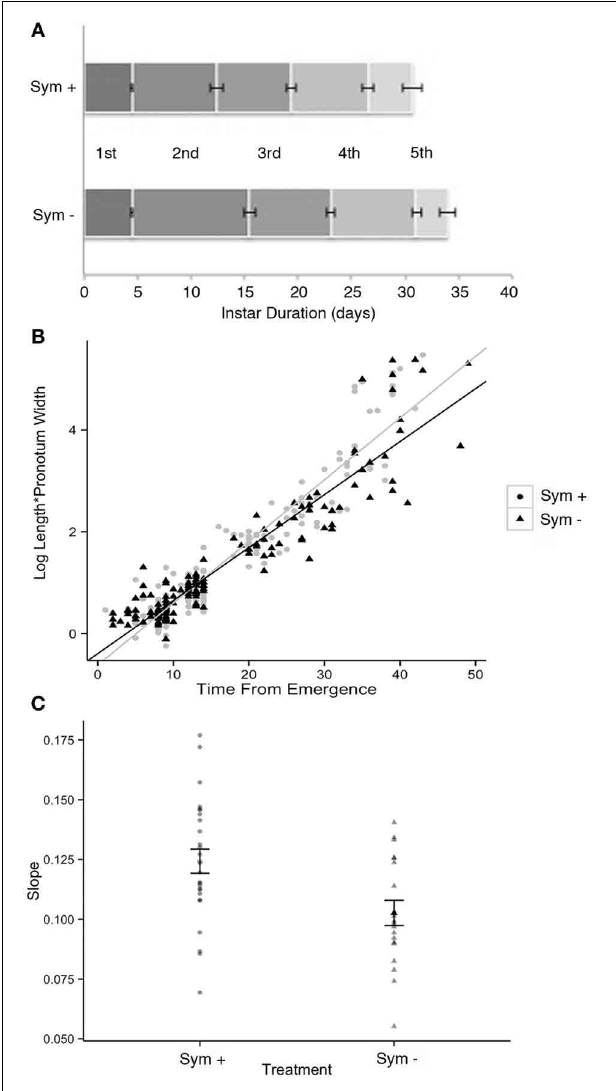
FIGURE 12 | Development of symbiotic (Sym + ) vs. symbiont-deprived (via surface sterilization of the egg masses; Sym − ) Sibaria englemani nymphs. (A) Stadia durations were equal in both symbiotic and aposymbiotic nymphs for the first, third, fourth, and fifth instars ( p = 0 . 87, p = 0 . 26, p = 0 . 17, and p = 0 . 26, respectively, Wilcoxon’s rank). However, symbiont-deprived nymphs experienced significantly elongated second stadia (9.1 ± 2.9 d for aposymbiotic vs. 7.9 ± 2.9 d for symbiotic nymphs, p = 0 . 0001, Wilcoxon’s rank with Bonferroni correction). Symbiont depression did not significantly influence total developmental duration (first to fifth instar). (B) Linearized growth rates for symbiotic and symbiont-deprived nymphs. (C) Averages of the slopes of the linearized growth rates from (B) (difference p = 0 . 005, Welch 2-sample t -test).